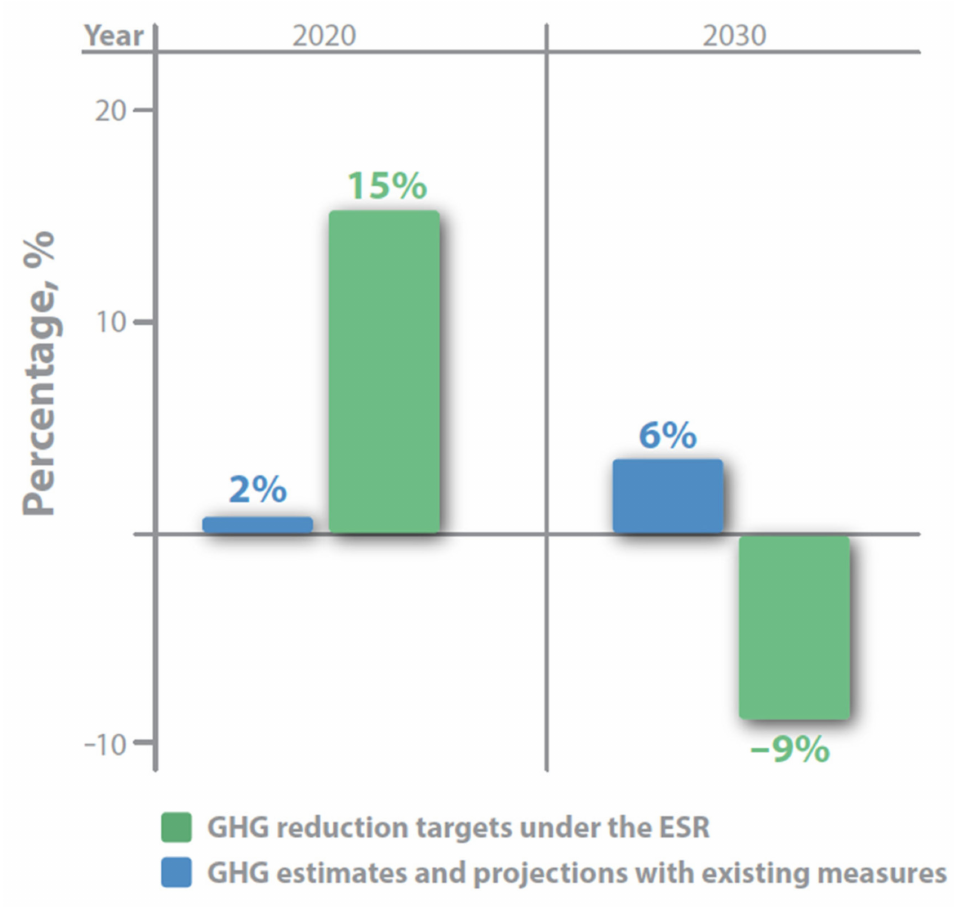
Figure 8. GHG emission targets for Lithuania by ESR,